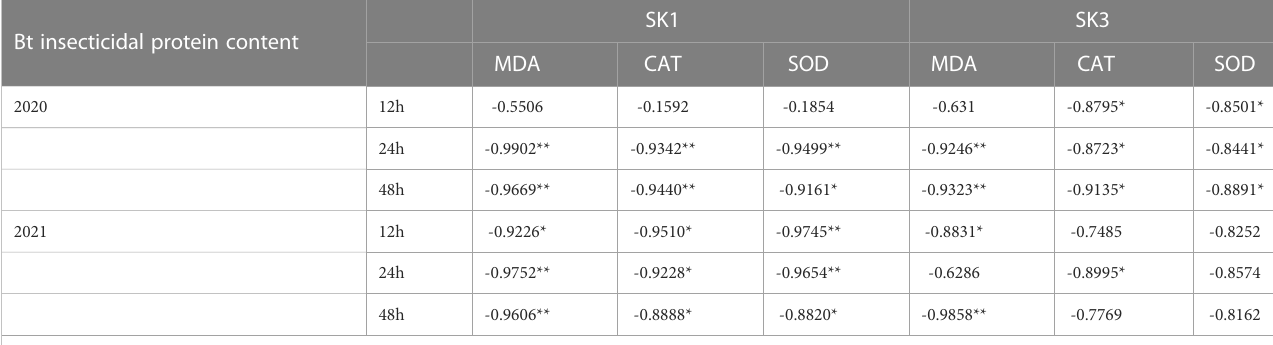
Asterisks indicate signi fi cance at 0.05 (*) and 0.01 (**)